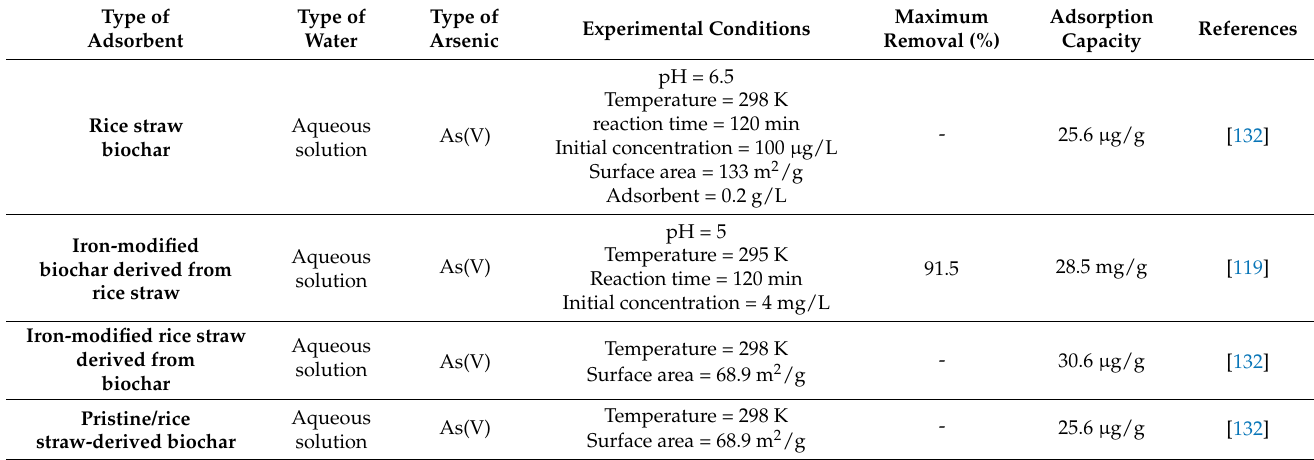
Table 12. Arsenic adsorption capacities by rice straw, synthesized rice straw, and rice polish (rice